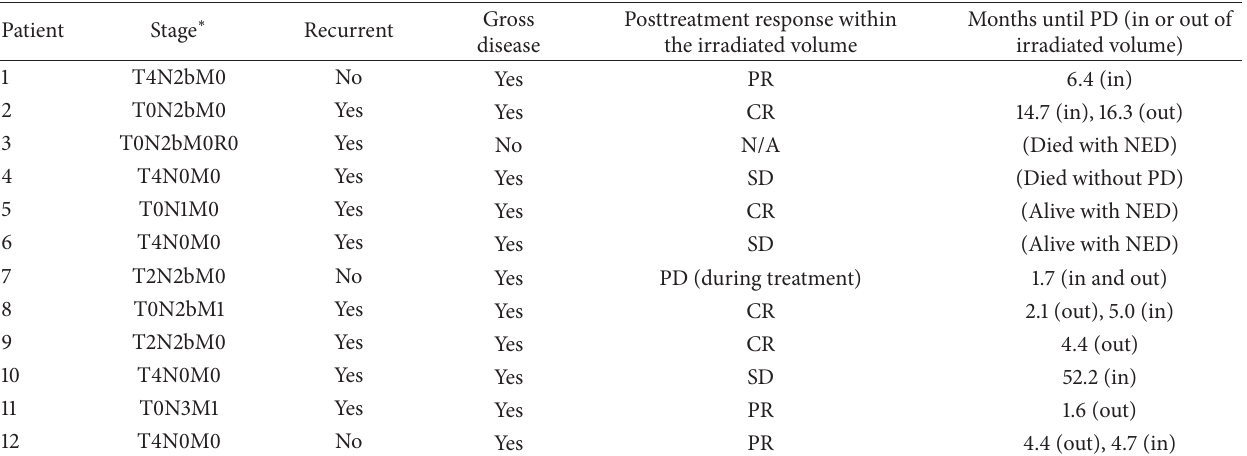
Table 2: Disease characteristics and treatment